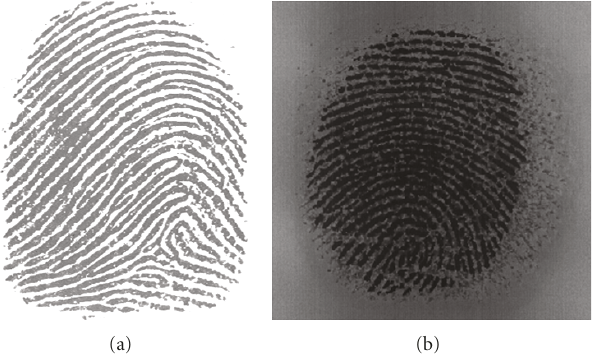
Figure 1: Two fingerprint images originated from two di ff erent